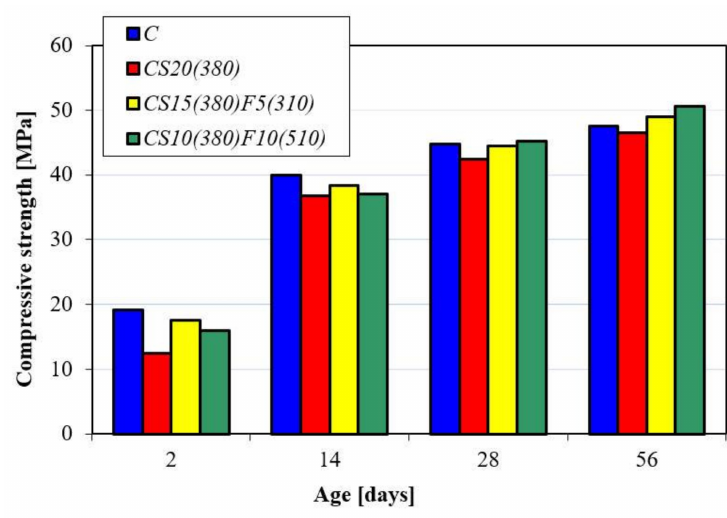
Figure 6. Compressive strength of concretes.